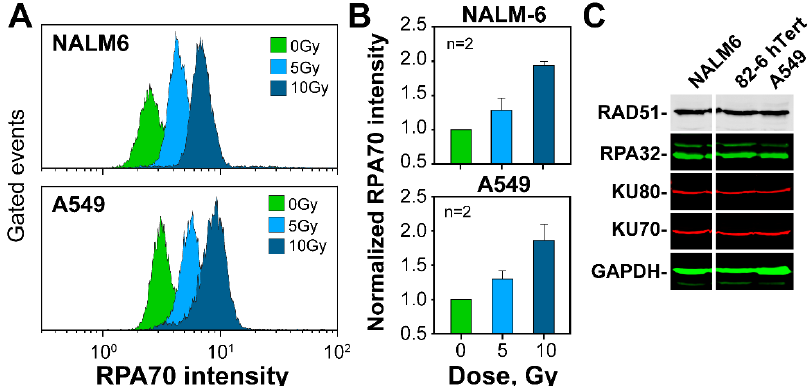
Figure 5 . NALM6 and A549 cells show similar levels of DNA end-resection during DSB processing: ( A ) Representative flow cytometry histogram plots indicating the distribution of RPA70 intensity in non-irradiated cells (0Gy) and cells irradiated with 5 or 10 Gy of X-rays. Only G 2 -phase cells are included in the analysis. The gates used for the selection of G 2 -phase cells are shown in Figure S6; ( B ) Quantification of the histogram plots shown in Figure 5A; ( C ) Western blot analysis in NALM6, 82-6 hTert and A549 cell lines, of protein factors involved in the repair of DSBs. Uncropped Western blot membranes are shown in Figure